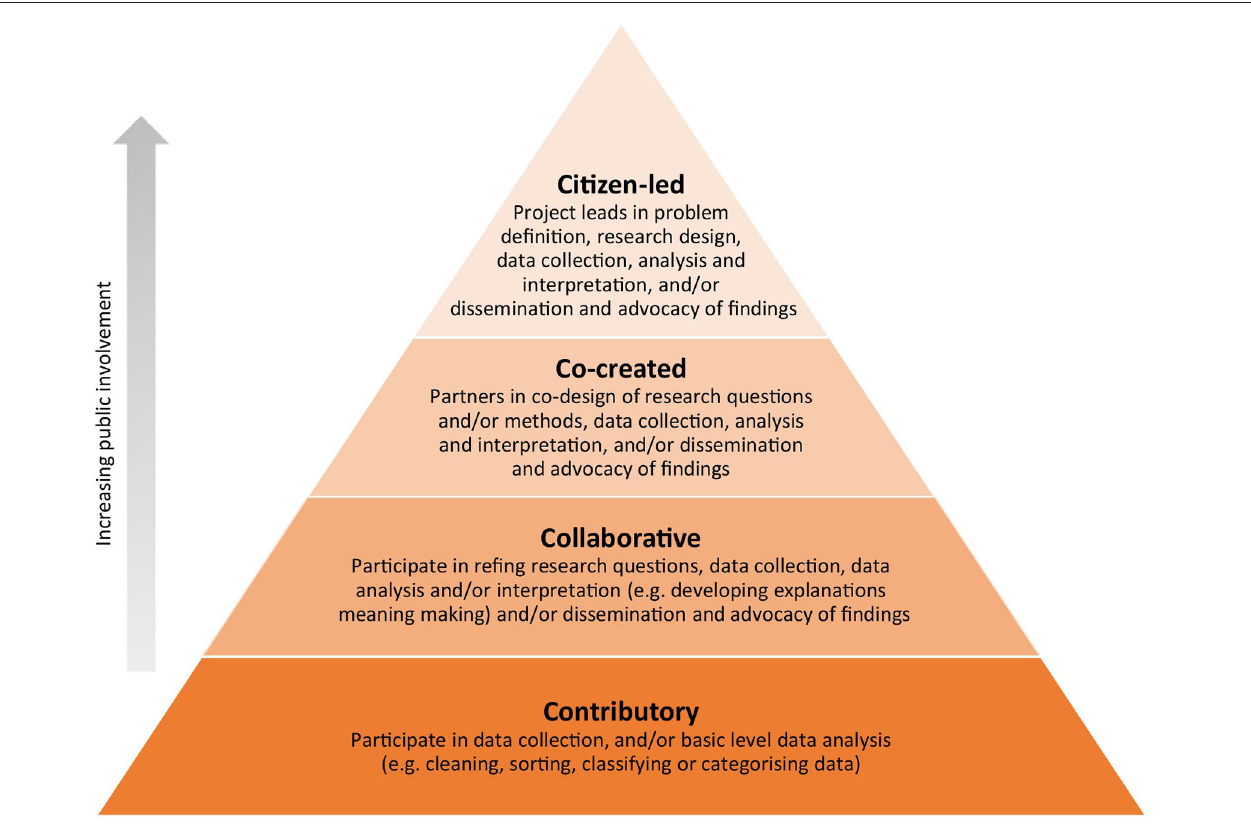
FIGURE 1 | Four models of citizen science characterized by increasing levels of public involvement in the research process. Adapted from Den Broeder et al. (19) and English et al.